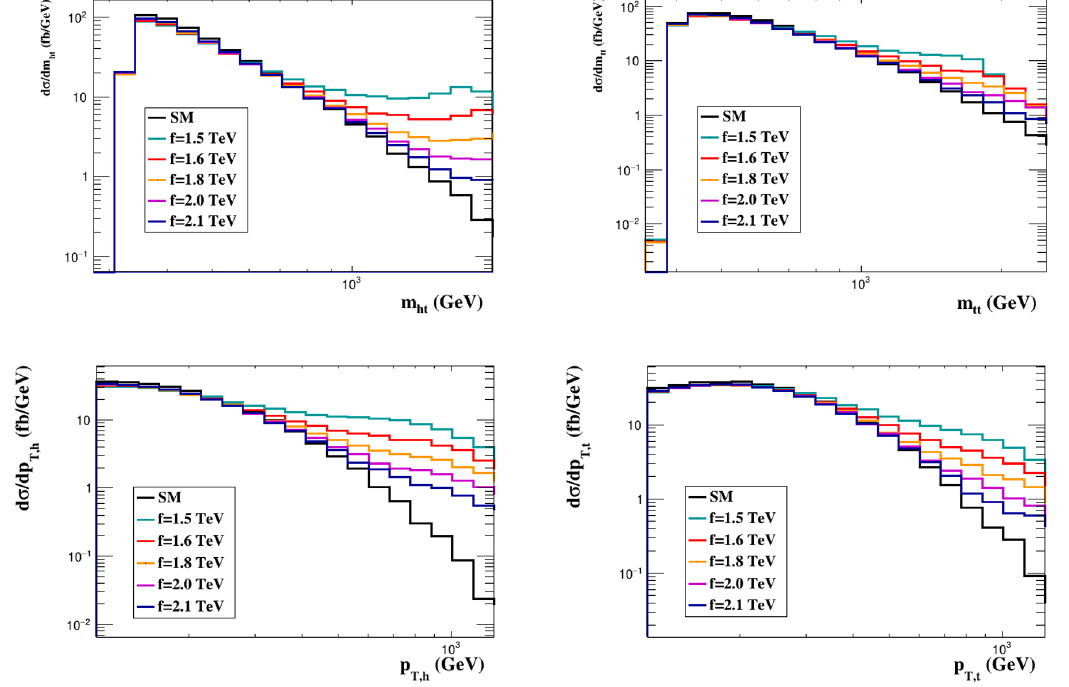
Figure 12 . Invariant mass and transverse momentum distributions for the tth process with MCHM 5 form factors. Signal simulation done in MadGraph5_aMC@NLO and kinematic analysis in MadAnalysis5 [49]. The black curve is the SM prediction and the colored ones are the form factors for different values of the compositeness scale. The ratio of mass to f is fixed as g 1 = 1 . 1 and g 4 = 1 . 55 for the MCHM 5 fermionic resonances that enter the form factor